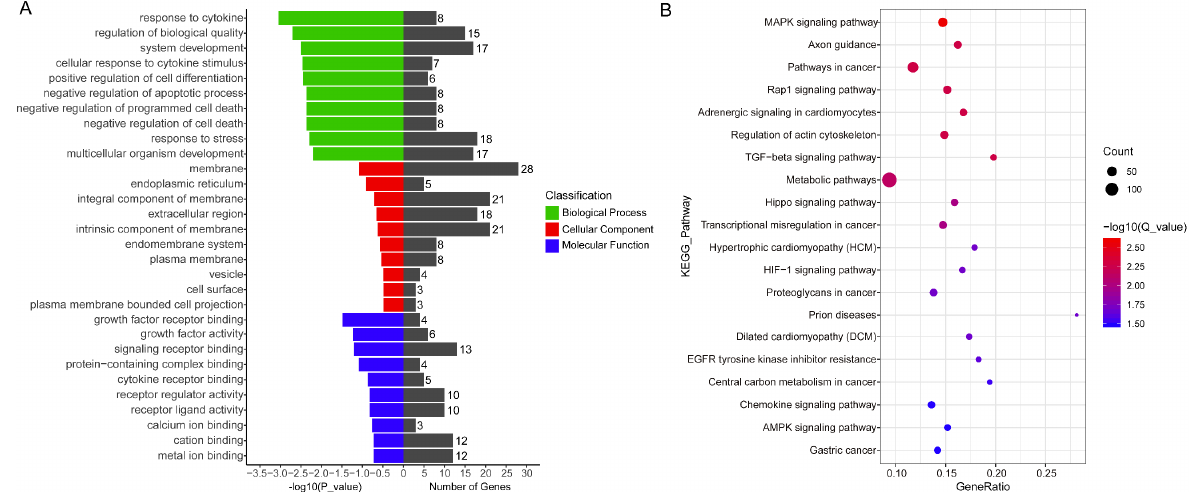
Figure 6. Functional analysis of the ceRNA network. ( A ) GO enrichment analysis of the ceRNA network. ( B ) KEGG pathways analysis of the ceRNA network.